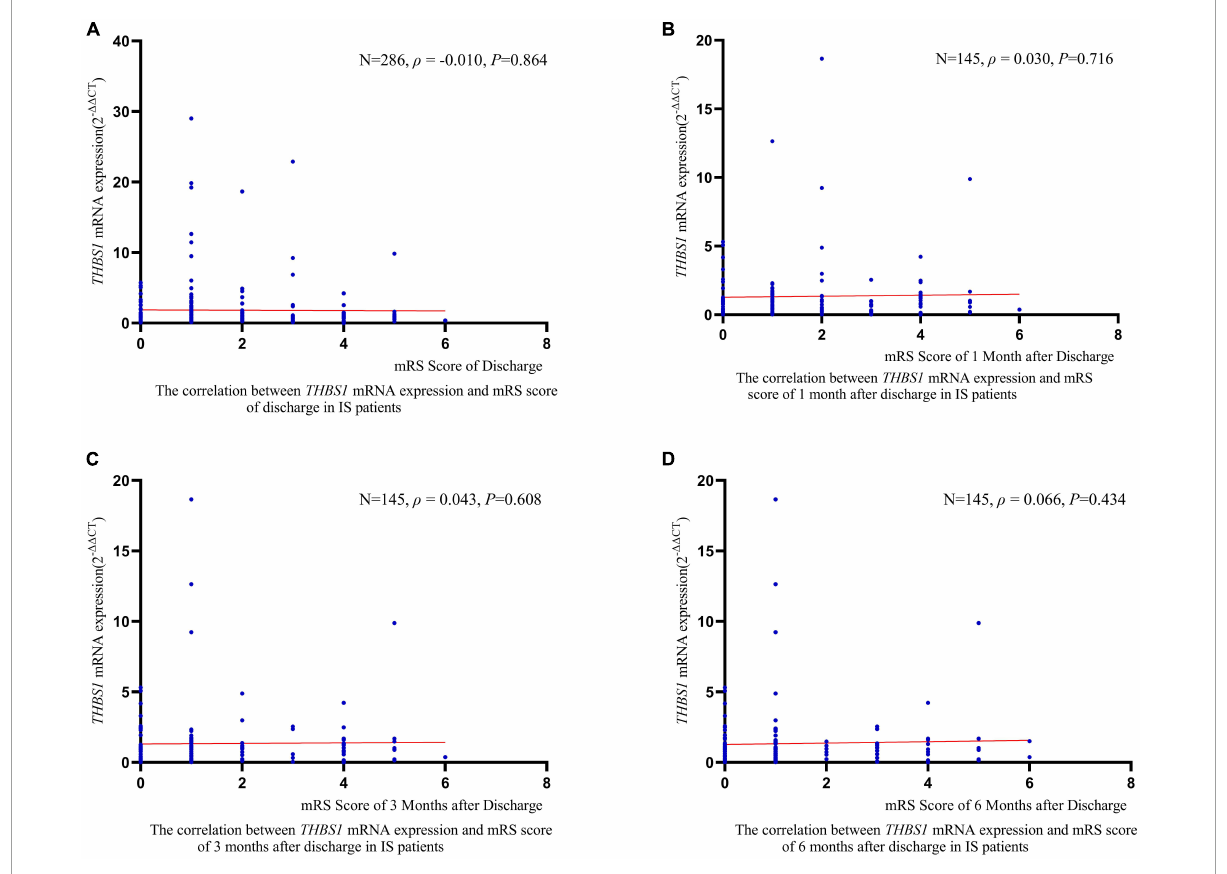
FIGURE5 The correlation between THBS1 mRNA expression and mRS scores of different periods after discharge in IS patients. THBS1 mRNA expression has no significant relevance to mRS scores of different periods after discharge in IS patients (all P -values >